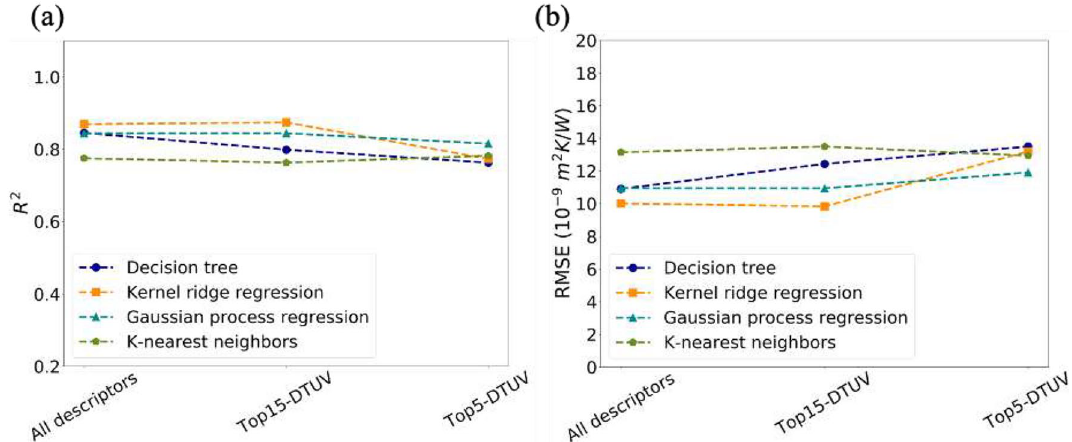
Figure 5. R 2 ( a ) and RMSE ( b ) of test data (holdout set) predicted by models built by all descriptors, 15 common descriptors, and 5 common descriptors under shuffled cross-validation.